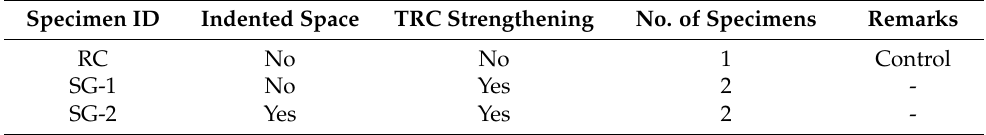
Table 2. Characteristic of slab specimens for flexural test.